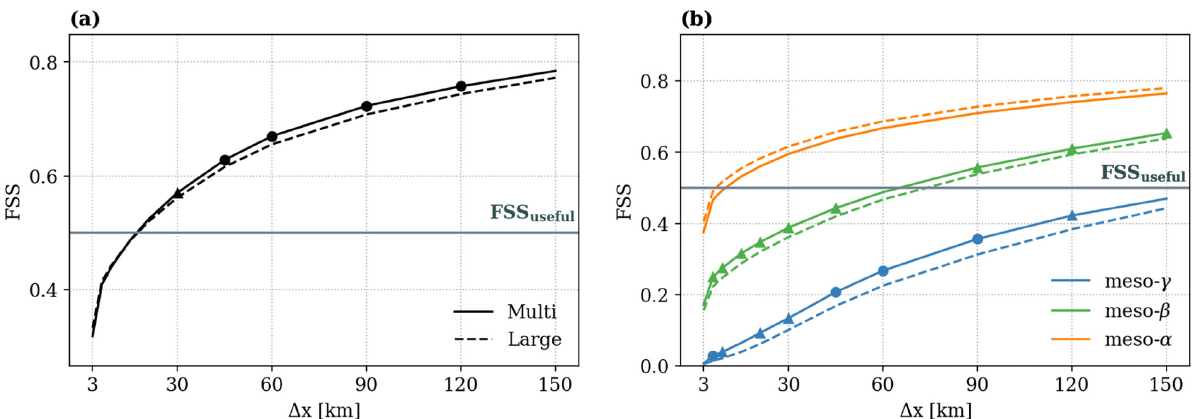
Figure 11. FSS as a function of neighborhood sizes for NMEPs derived with the 35 dBZ threshold for ( a ) the full field and ( b ) meso-alpha, meso-beta, and meso-gamma subfields of 9h forecasts aggregated over 25 cases. Dots along the FSS curves indicate statistically significant differences determined by Wilcoxon rank sum test, with filled (open) dots representing improved (degraded) skill for MULTI at the 10% confidence level.